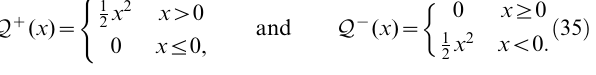
Table 4. Comparison of the three solutions using the fixed point error metric